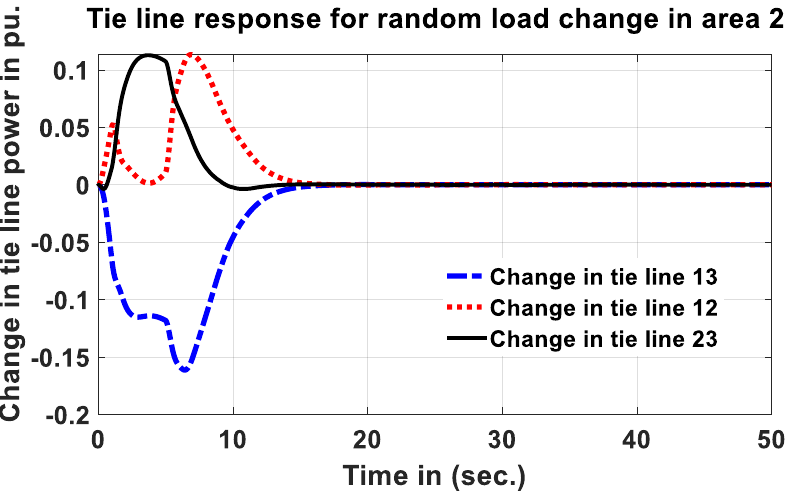
Figure 25. Change in tie-line power responses of area 1, area 2, and area 3 for random load change in area 2 only.